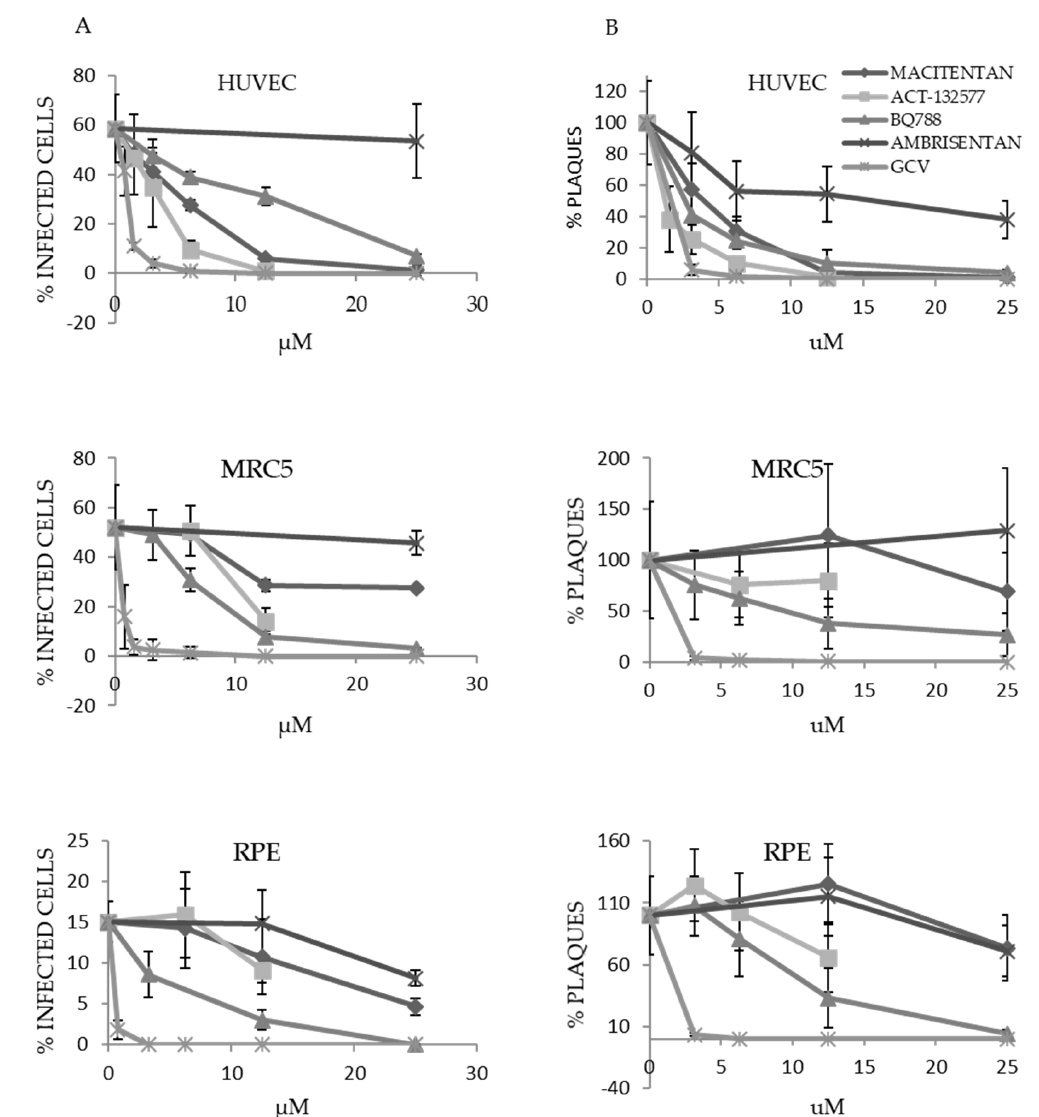
Figure 4. ETR antagonists at low concentrations inhibit production of HCMV in various cell types. HUVECs, MRC5 and RPE-1 cells were treated with low concentrations of ETR antagonists or ganciclovir (GCV) and exposed to HCMV. Seven days later, the virus-containing supernatant was collected or, in the case of RPEs, viral particles were extracted from cells by sonication. The harvested virus containing supernatant was used to infect MRC5 cells. ( A ) The percentage of IE-positive MRC5 cells was determined one day after infection. ( B ) The harvested virus was subjected to serial dilution and titered by a plaque assay in MRC5 cells. Two hours after infection, the supernatant was replaced with methylcellulose-containing medium. At 14 days post infection, the number of plaques formed was quantified from wells where plaques were easy to distinguish, and the titers were calculated. Values are presented as percentage of control without drugs (mean ± SD). Table 3. HCMV infected HUVECs, MRC5 and RPE were treated with different concentrations of ETR antagonists or Ganciclovir and viral output was calculated from the percentage of IE-expressing cells one day after infection. These re- sults were obtained from data in figure 4.